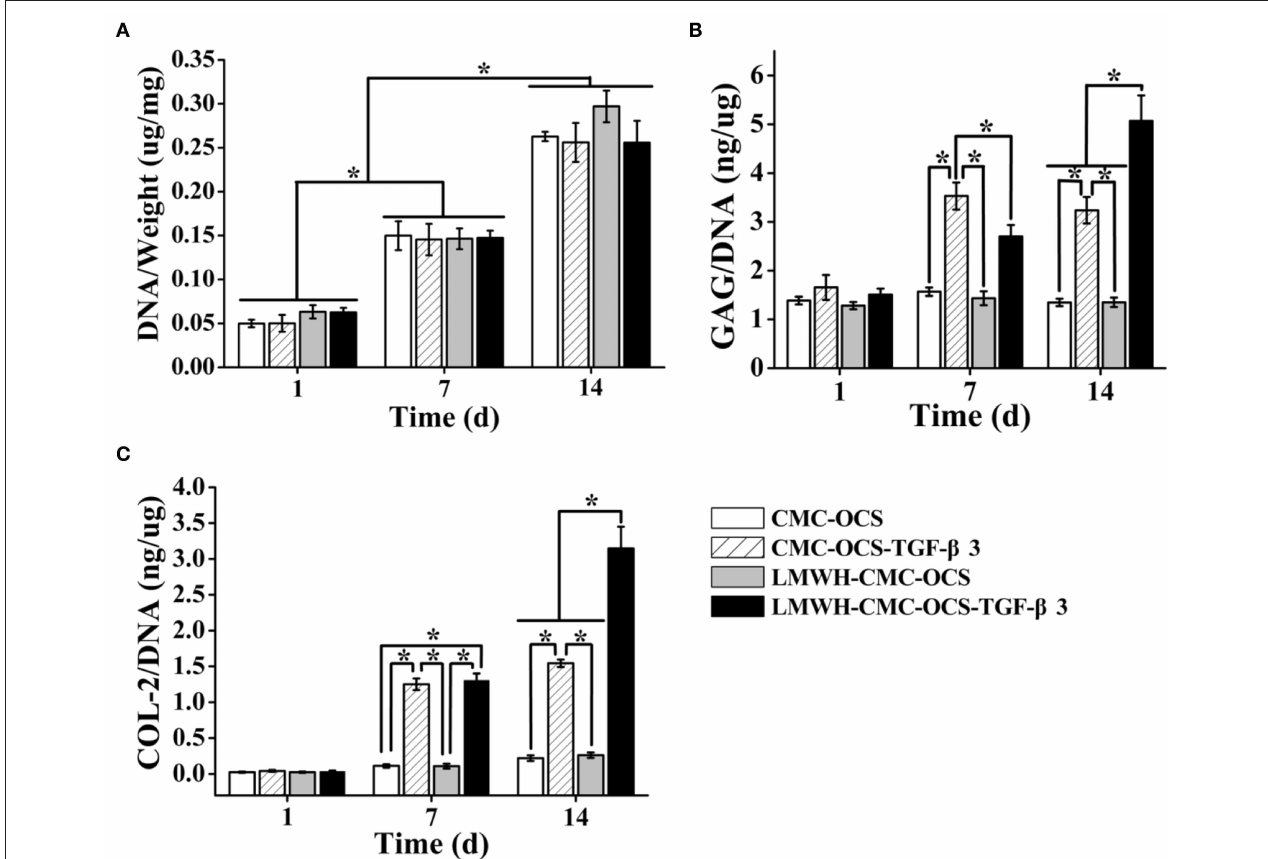
FIGURE 8 | (A) DNA contents of four cell-hydrogel composites increased over time ( n = 3, * P < 0.05). (B) GAG and (C) COL-2 deposition on four hydrogels by PB-MSCs at different time points ( n = 3, * P < 0.05).